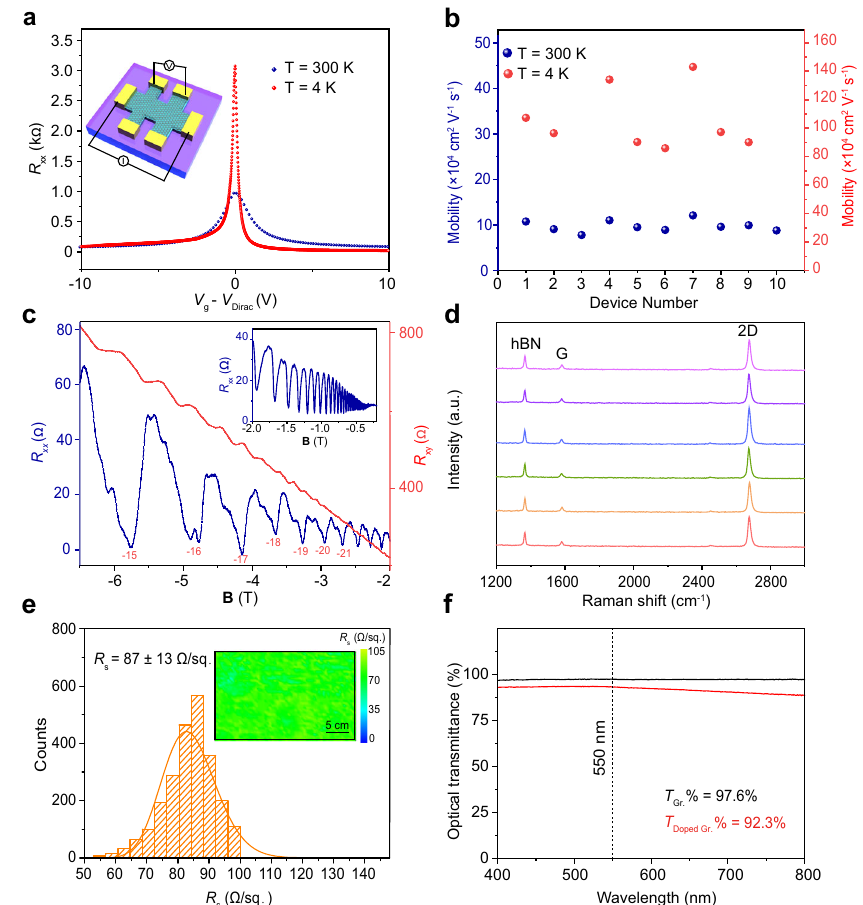
Fig. 4 The properties of transferred graphene. a Typical transfer curves of as-transferred graphene after encapsulation by hBN and one-dimensional contacting at 300 K (navy blue) and at 4 K (red). Inset: Illustration of the measured Hall bar devices of encapsulated graphene. b The statistics of obtained carrier mobilities of the encapsulated graphene at 300 K (navy blue) and at 4 K (red). c R xx (navy blue) and R xy (red) as a function of magnetic fi eld ( B ) at a fi xed gate voltage ( − 50 V). Inset: R − 0.2 to − 2 T. R xx as a function of B scanning from xx is the longitude resistance, which can be obtained according to the equation: R xx = V xx / I ds , and R xy is the Hall resistance which can be obtained by R xy = V xy / I ds . d Raman spectra of as-transferred graphene encapsulated by hBN. e Sheet resistance statistics of graphene on PET substrates doped by PEDOT:PSS. Inset: Corresponding A4-sized sheet resistance mapping of the doped graphene. f Ultraviolet-visible (UV-Vis) transmittance spectra of graphene fi lms (black) and doped graphene fi lms by PEDOT:PSS on PET substrates (red). Note that graphene in ( a , c ) was transferred by cedrol (10 wt%)/PMMA; devices No. 1, 2 were transferred by borneol (10 wt%)/PMMA; devices No. 3, 4, and 5 were transferred by alpha-terpineol (10 wt%)/PMMA; devices No. 6, 7, 8 were transferred by linalool (10 wt%)/PMMA and devices No.9, 10 were transferred by cedrol (10 wt%)/PMMA. Their corresponding Raman spectra were shown in ( d ). Note that the mass fraction of borneol in n-heptane should not be higher than 10% to avoid precipitating from the PMMA